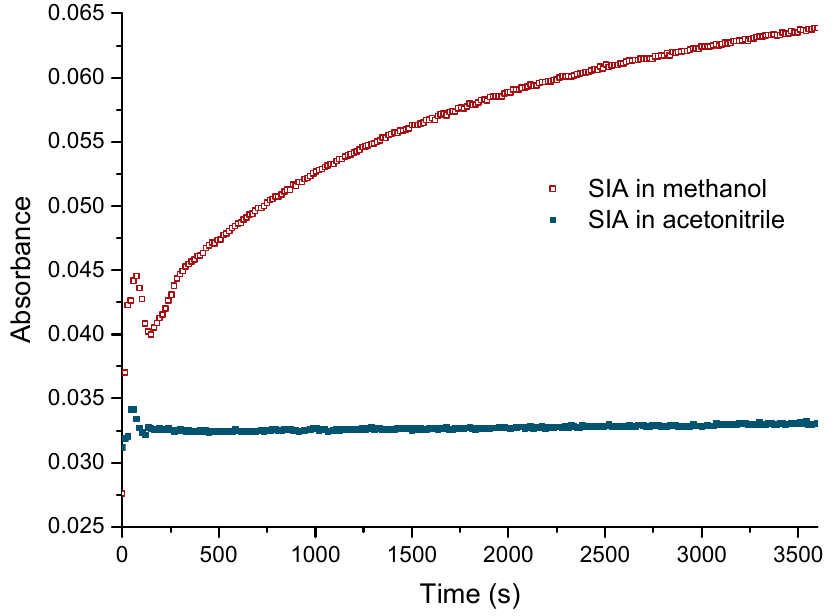
Figure 2. Solvolysis of succinimidyl iodoacetate (SIA) by methanol and acetonitrile. Monitoring of UV absorbance at 260 nm.